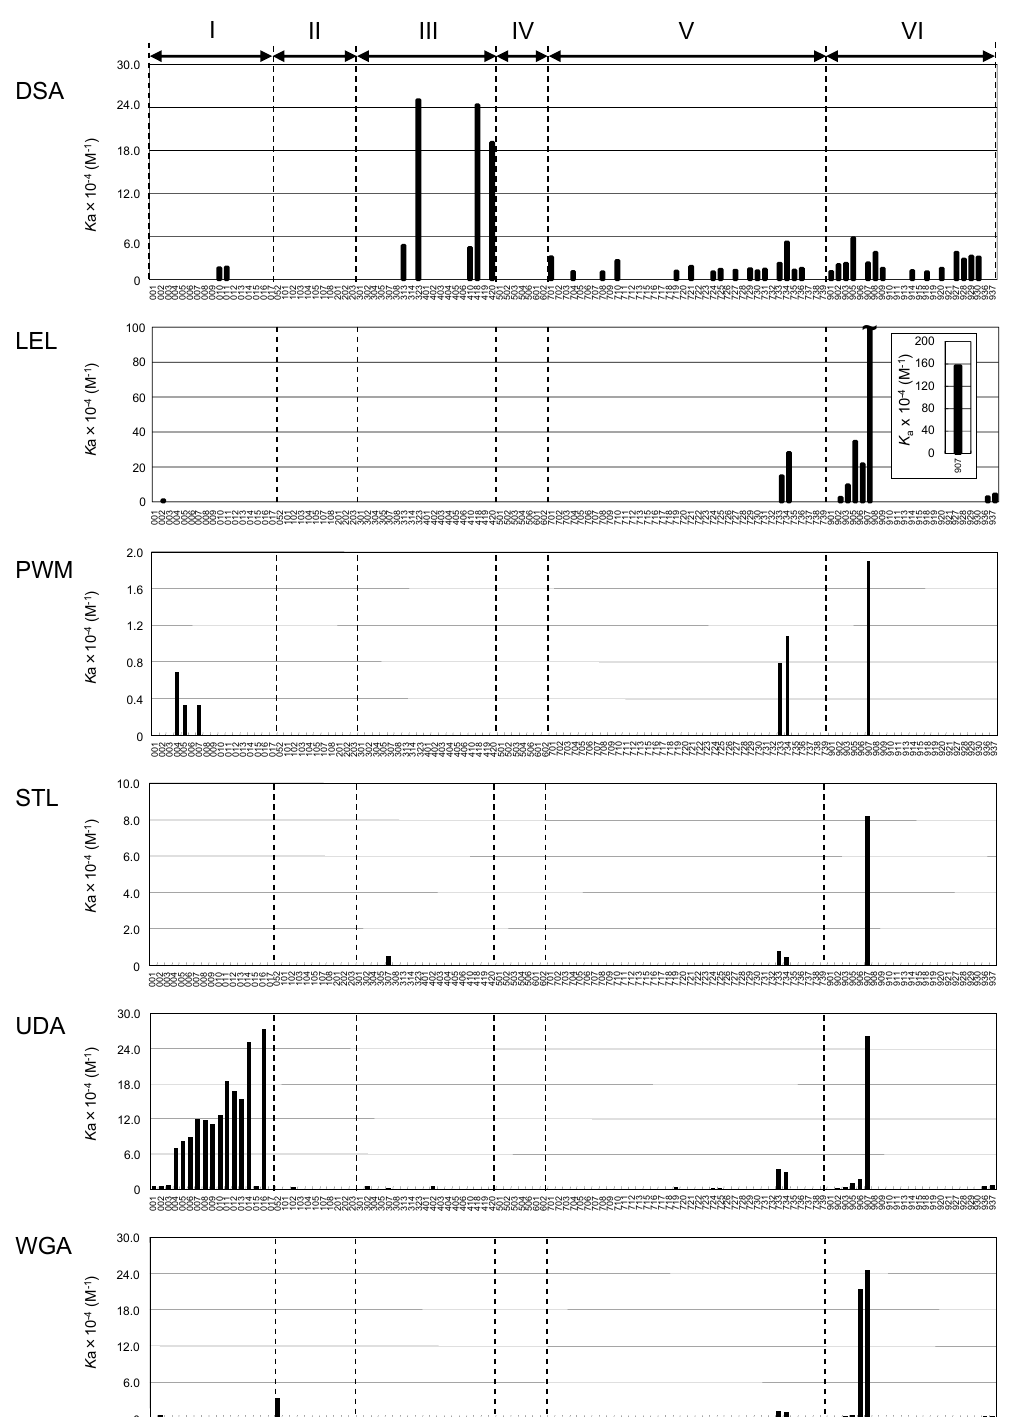
Figure 4. Bar graph representation of affinity constant ( K a ) was made for DSA, LEL, PWM, STL, UDA, and WGA against a panel of PA-oligosaccharides. The small Arabic numbers at the bottom of each graph correspond to sugar numbers indicated in Figure 3, whereas the Roman numerals at the top represent types of glycans, i.e., high-mannose-type (I), agalacto-type (II), asialo-type (III), sialo-type (IV) N -glycans, glycolipid-type glycans (V), and others (VI). For oligosaccharide structures and specifications of the lectin columns, see Figure 3 and Table 1, respectively. K d values obtained in this analysis are listed in Table